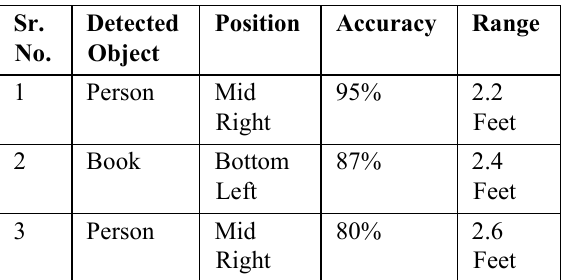
Table II. The Summary of output generated for frame